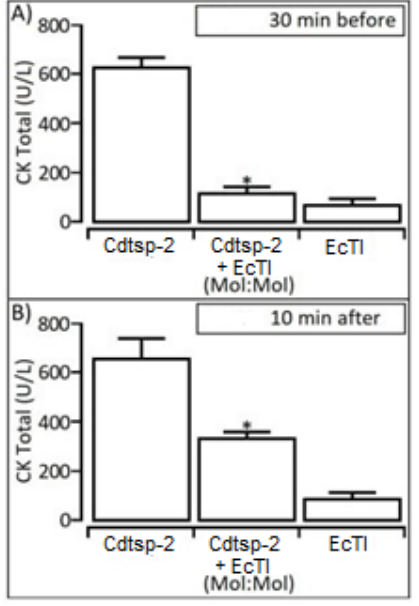
Figure 5. ( A ): Creatine kinase breakdown assay, revealing a signi fi cant decrease in the myotoxity of the protein when it was applied EcTI 30 min after Cdtsp-2. ( B ): There was no signi fi cant decrease in the myotoxicity of the protein when it was applied 10 min after the pure compounds. However, there was a decrease in myotoxicity when Cdtsp-2 was exposed to EcTI. Data were expressed as mean and standard deviation, and treatments with signi fi cant di ff erence marked with (*) and ANOVA was used as the statistical test, with Dunnet as the a posteriori test, F = 9.797, p = 0.0017.